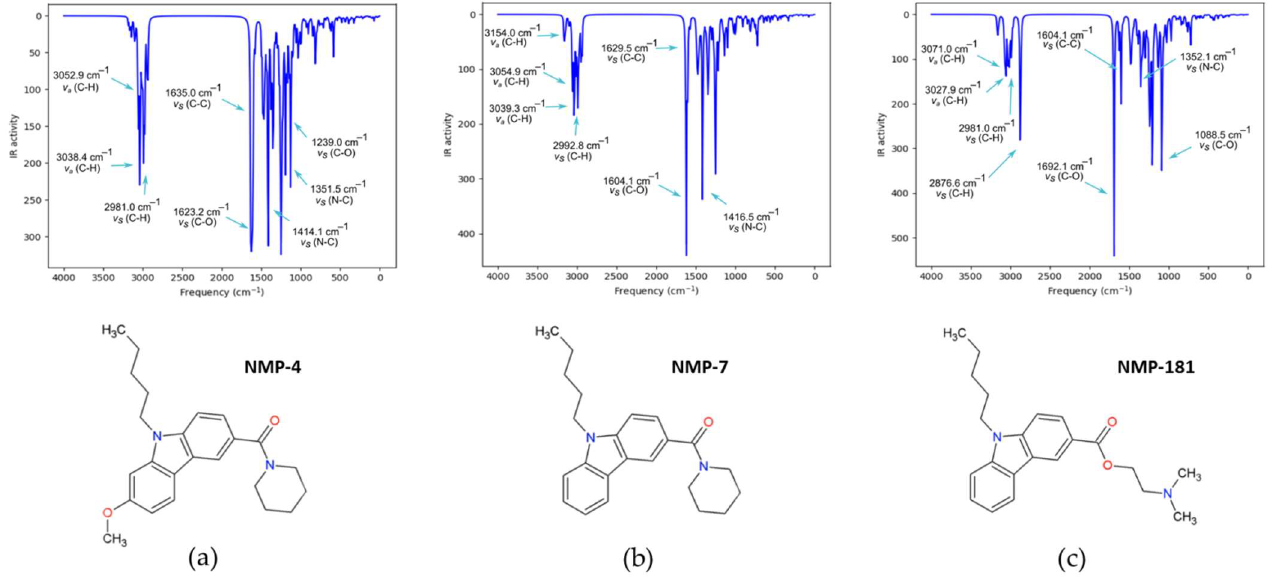
Figure 3. Theoretical IR spectra of NMP compounds: ( a ) NMP-4, ( b ) NMP-7, and ( c ) NMP-181 at BP86/cc-pVTZ level of theory in chloroform.